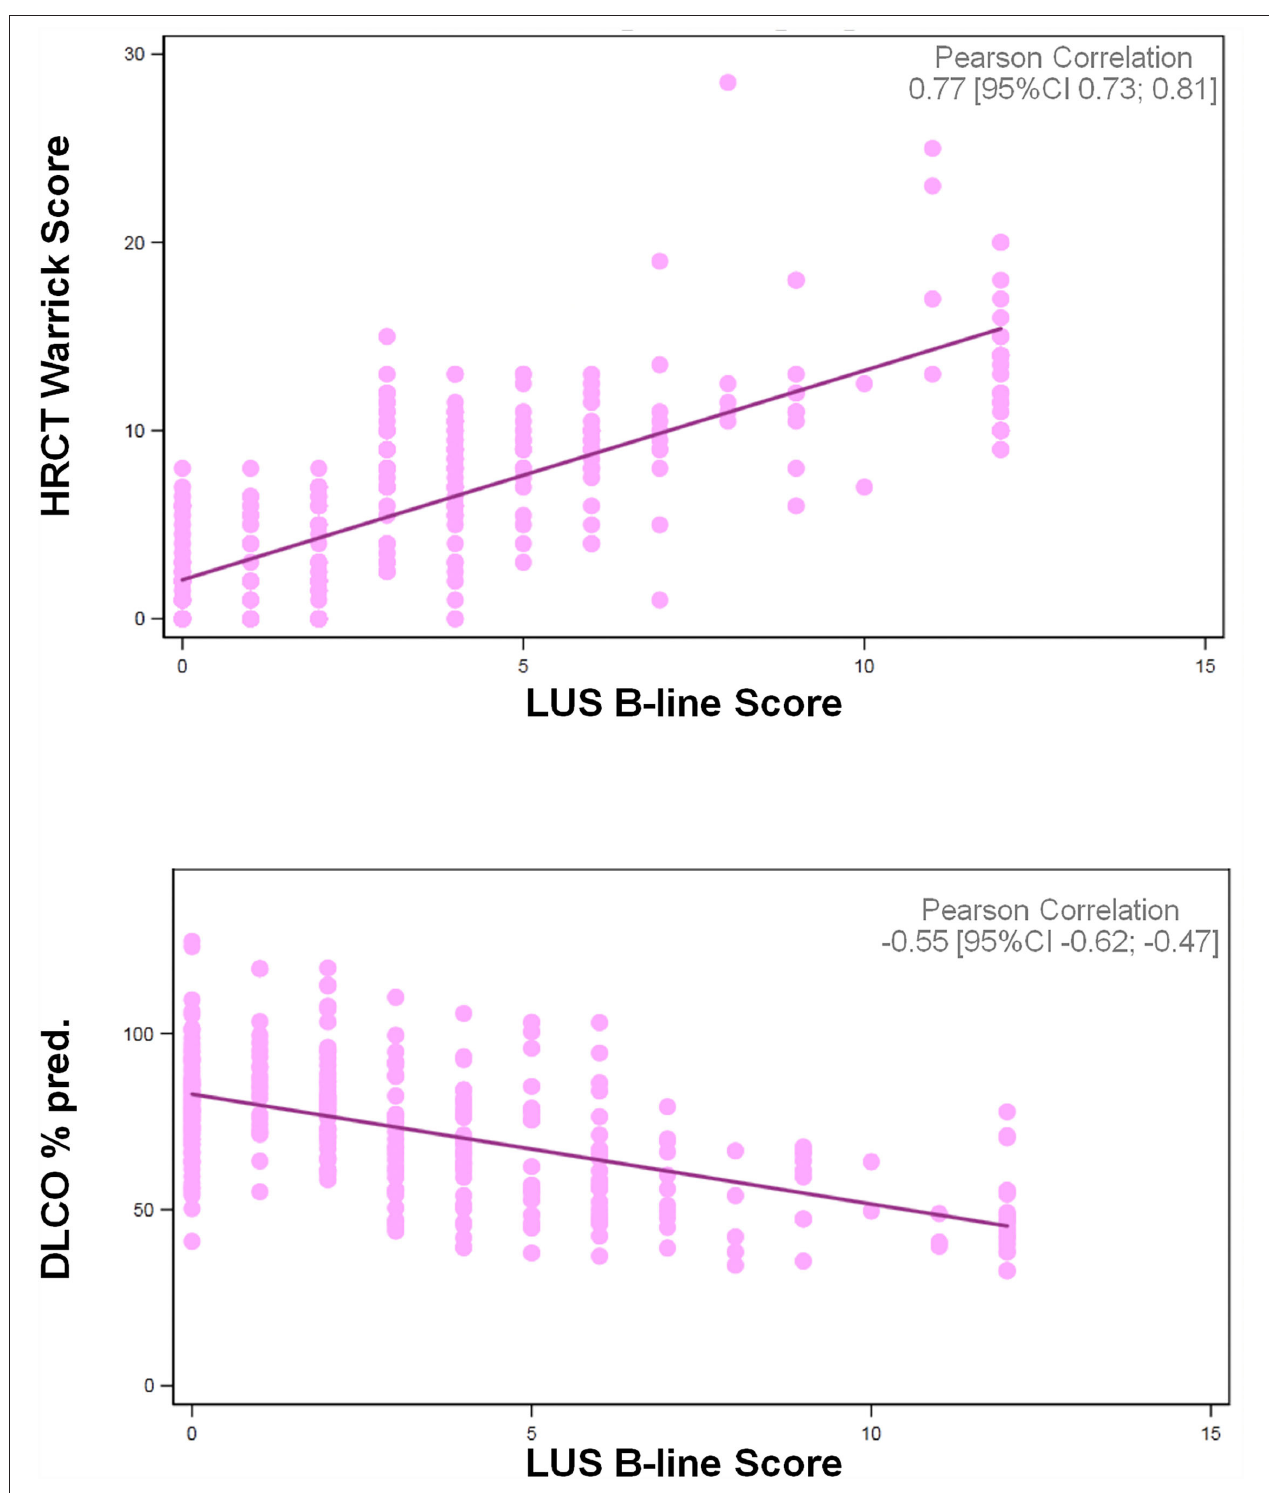
FIGURE 3 | Correlations of LUS B-line score with HRCT Warrick Score and DLCO%pred. influenced the primary objective. Another limitation is that we used the Warrick score, which has been validated in scleroderma- related ILD, to grade HRCT abnormalities because of the absence